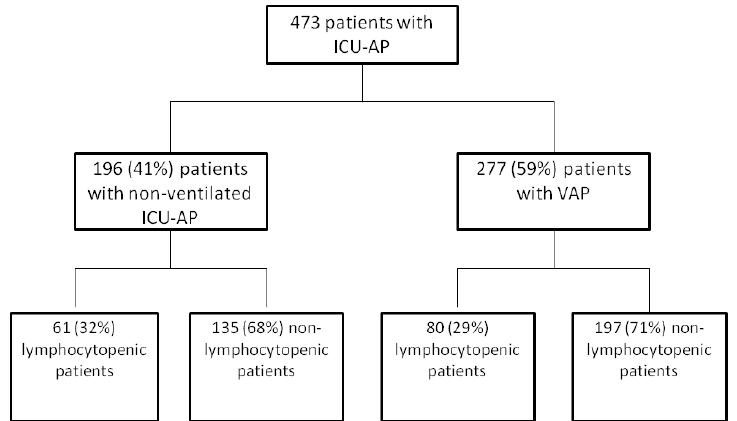
Figure 1. Flowchart. ICU-AP: intensive care unit-acquired pneumonia, VAP: ventilator-associated pneumonia.